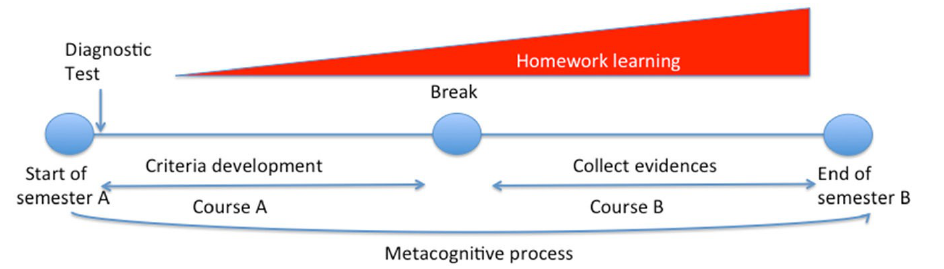
Figure 5. Characteristics of Teaching-Learning